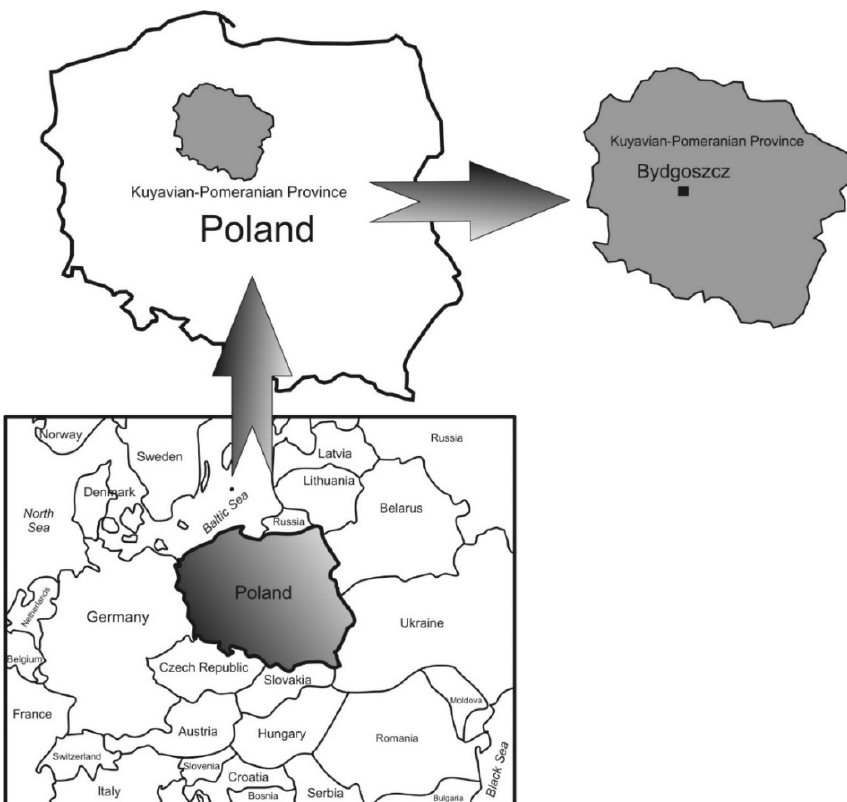
Figure 1. Geographical location of the Kuyavia region in Poland and Europe.